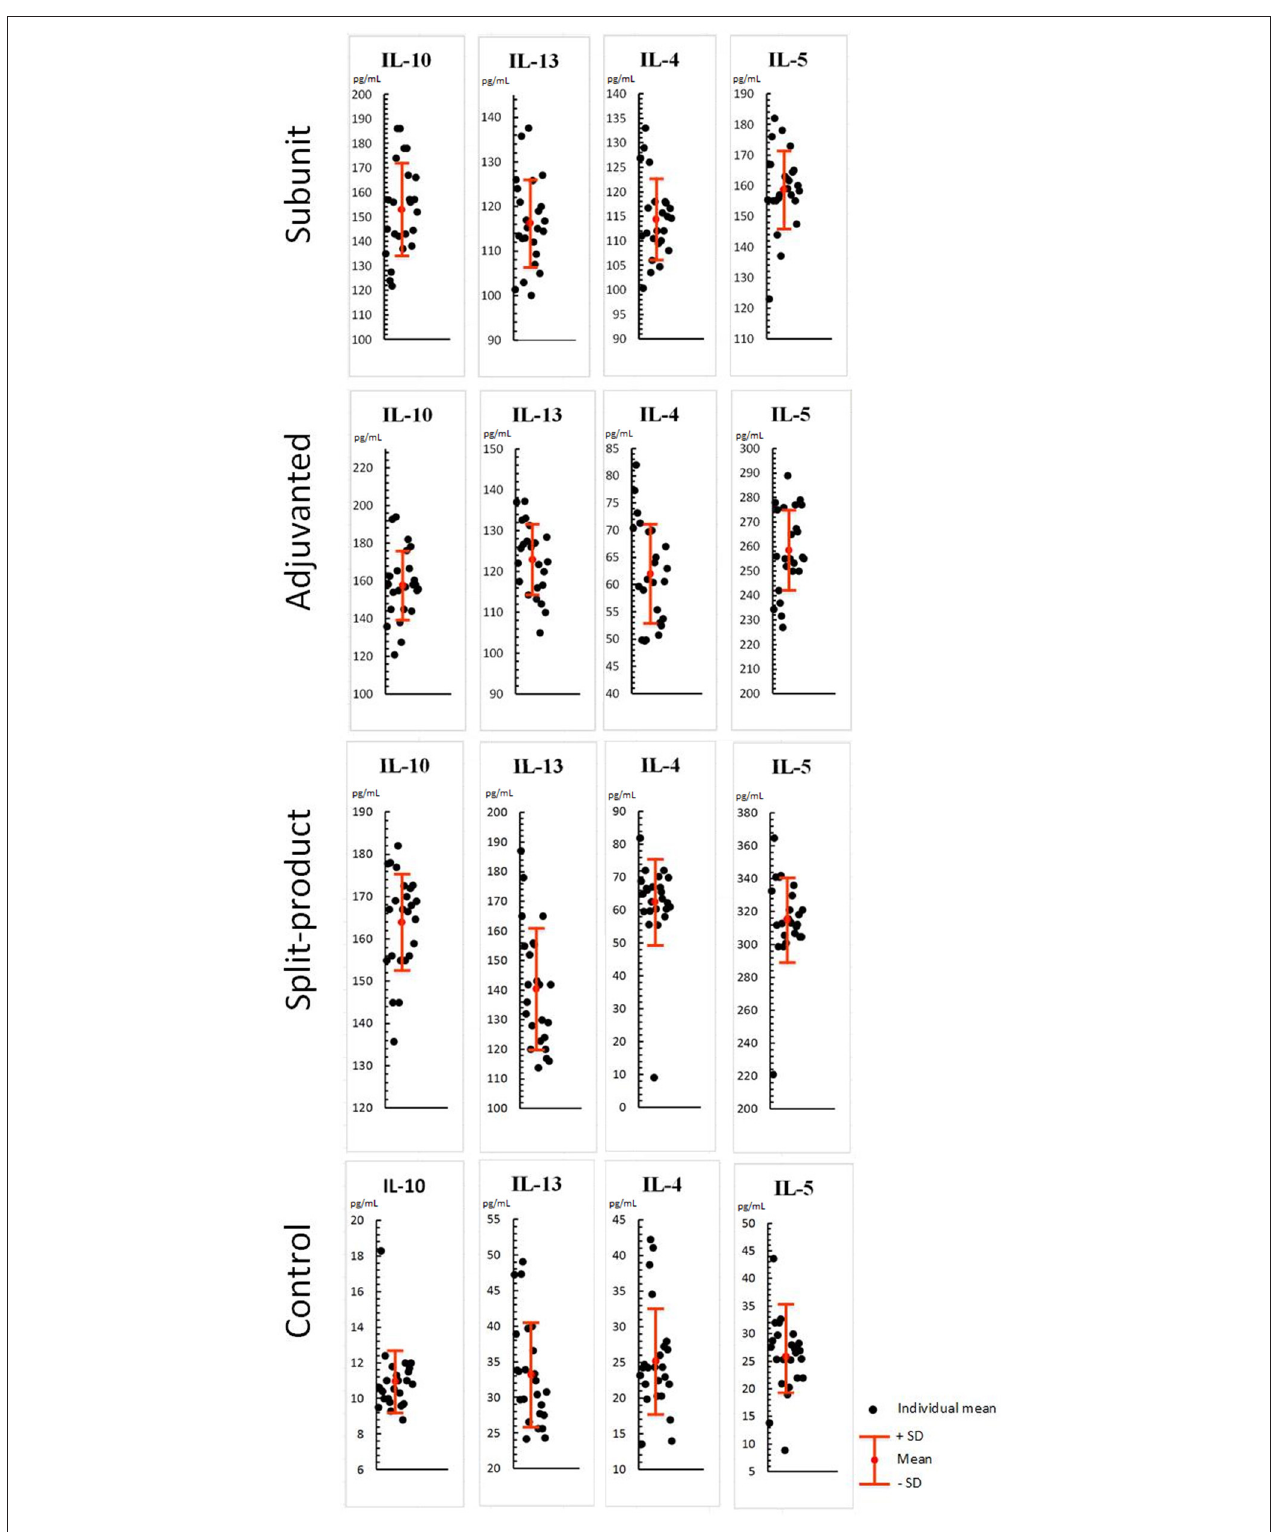
FIGURE 2 | Effect of vaccines against influenza on Th-2 cytokine levels in PBML culture. PBML were isolated from peripheral blood. Cytokine level in PBML supernatants was determined 24h after incubation with vaccines against influenza by flow cytometry. All data are shown as individual means, M (mean values) ± SD (standard deviation). The significance of differences between mean values at each time point was tested by Mann–Whitney rank sum tests for independent samples ( P ≤ 0.05).